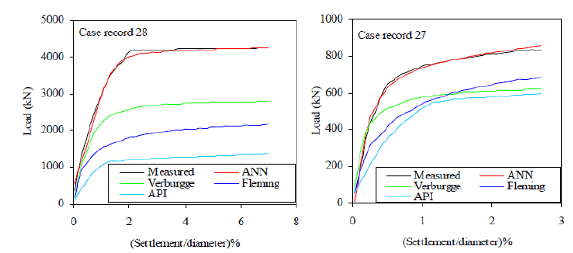
Figure 9. Comparison performance of ANN driven concrete piles model and load-transfer methods.